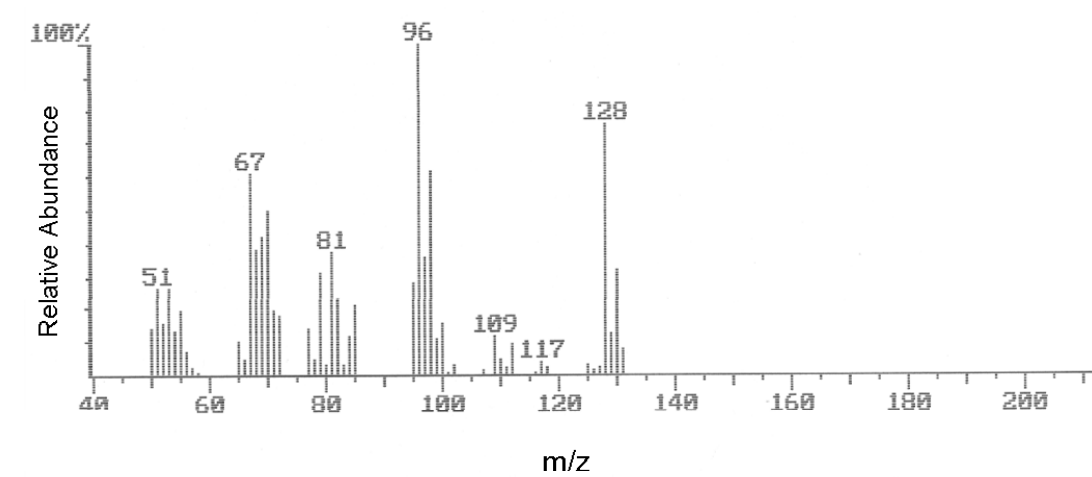
Figure 1. Mass spectra of cantharidin with base peaks at m/z 128 and 96 according to a Hewlett-Packard gas chromatograph.